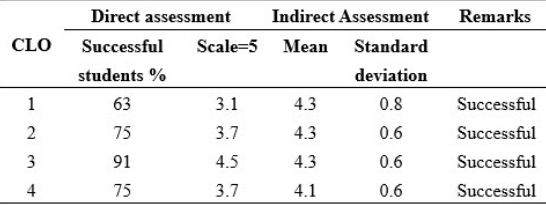
Table 7. PLO’s direct and indirect